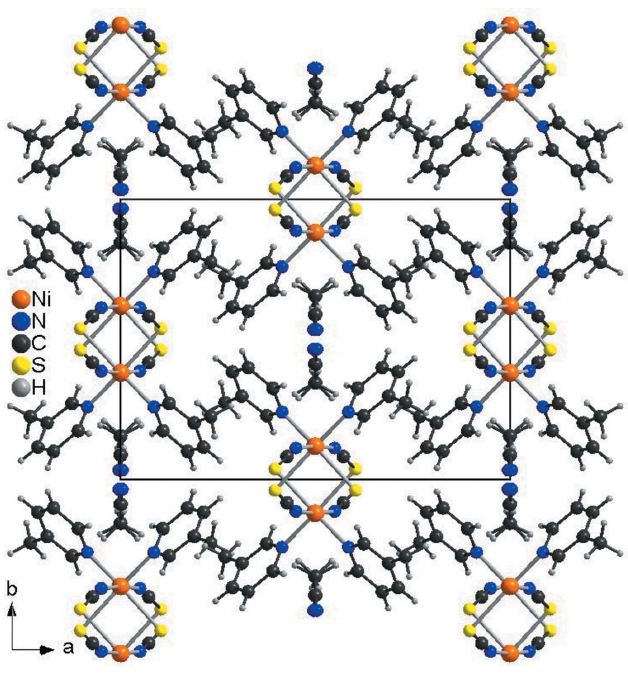
Figure 5 Crystal structure of the title compound with view along the crystal- lographic c